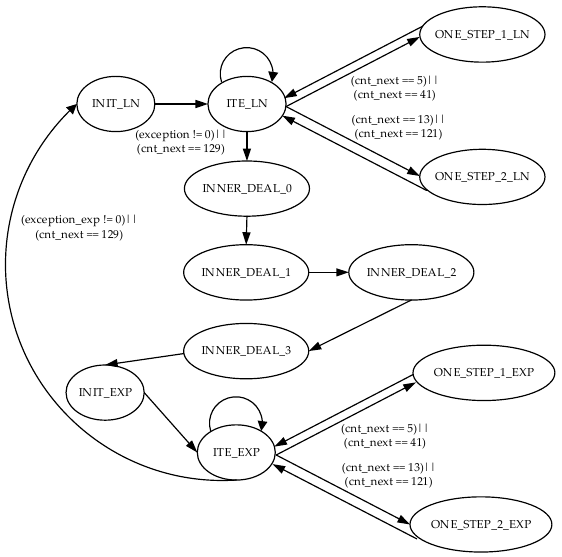
Figure 4. State transition diagram of the finite state machine.